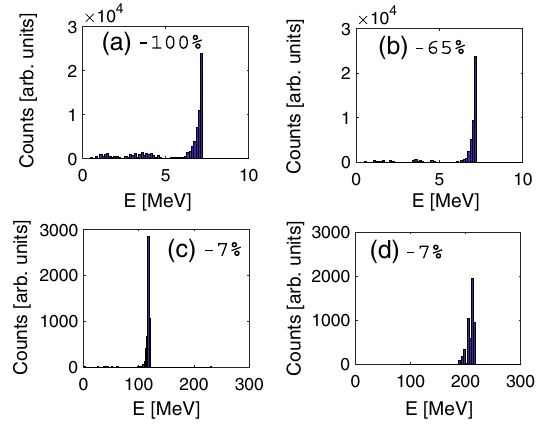
FIG. 16. Simulated energy spectrum of the dark current at (a) the location of the Faraday cup, (b) the entrance of the first accelerating cavity, (c) the exit of the second structure and (d) the end of the fourth structure. The percentage of the number macroparticles transmitted normalized to those at the FC is also shown. The rf pulse length assumed is 2 μ s.